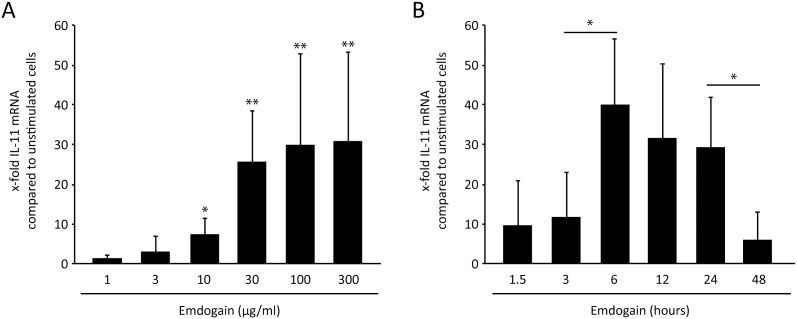
Dose- and time-response of Emdogain on IL-11 expression.Palatal fibroblasts were incubated with (A) various concentrations of Emdogain for 24 hours and for (B) various time-points with Emdogain at 100 µg/ml. RT-PCR was performed for IL-11 **P<0.01 compared to Emdogain control. The data represent two experiments with a total of three donors (n = 6).